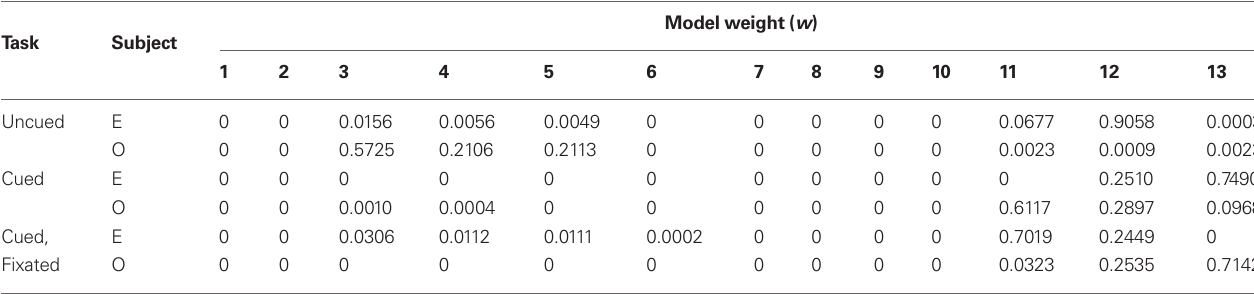
Table 3 | Akaike weights for each of the 13 fitted models and task conditions.